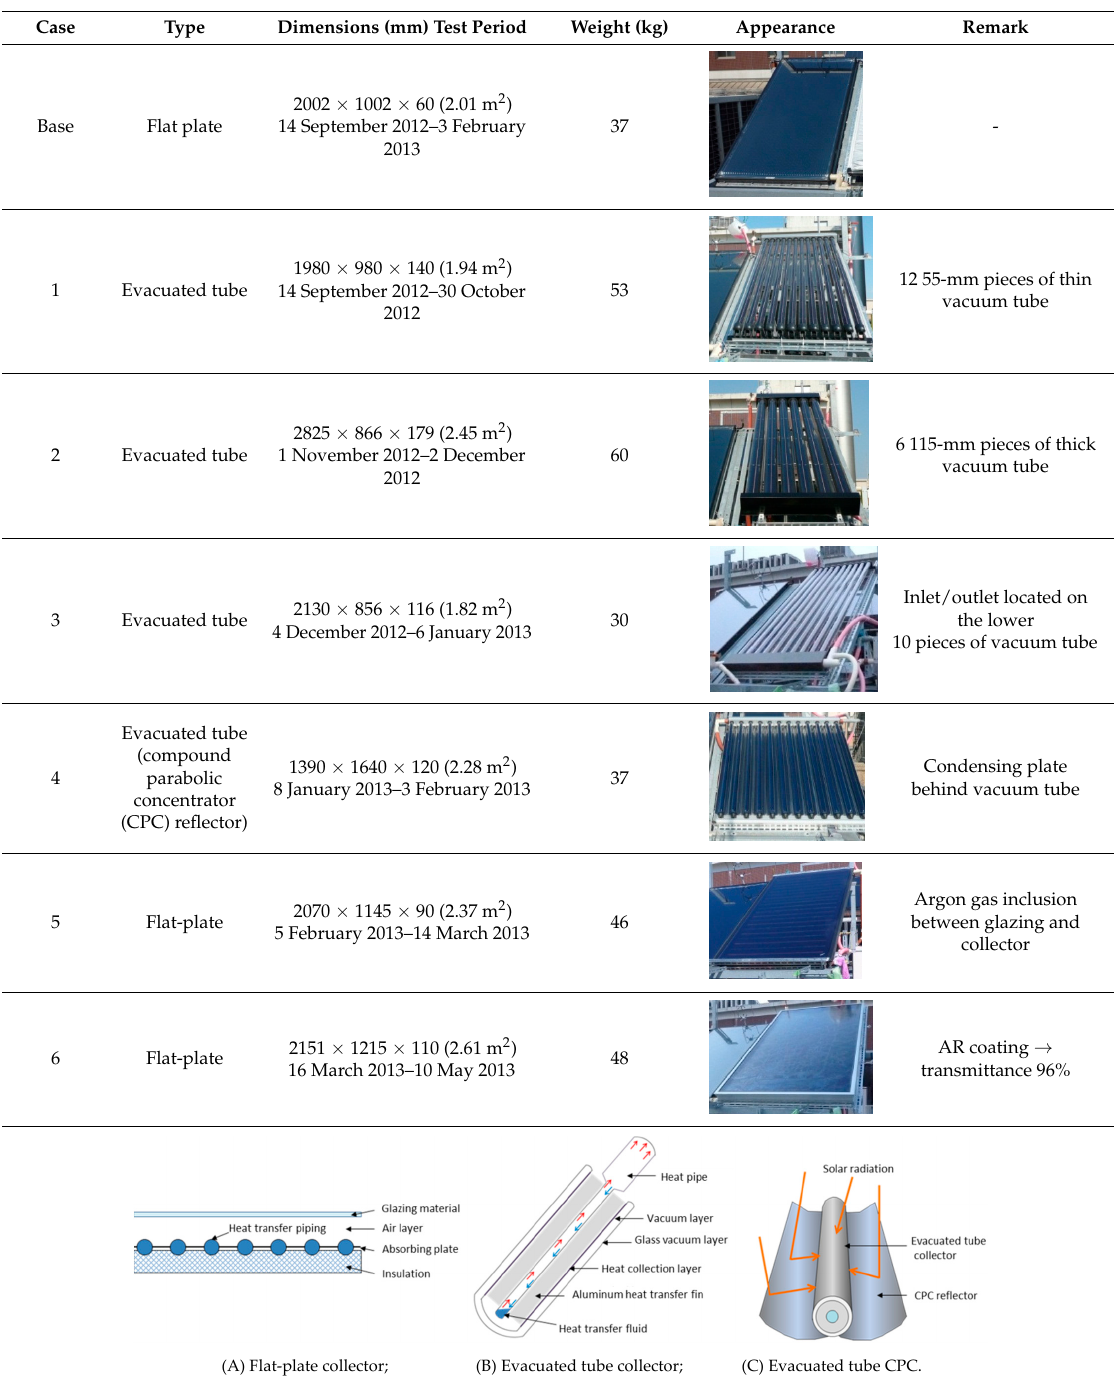
Table 3. Solar collectors used in the experiments.